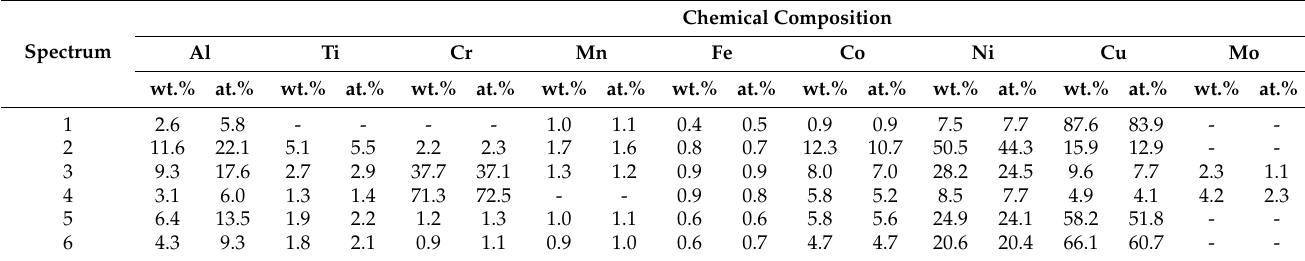
± 0.1, 2.1 ± 0.1 and 2.6 ± 0.1 GPa, respectively.